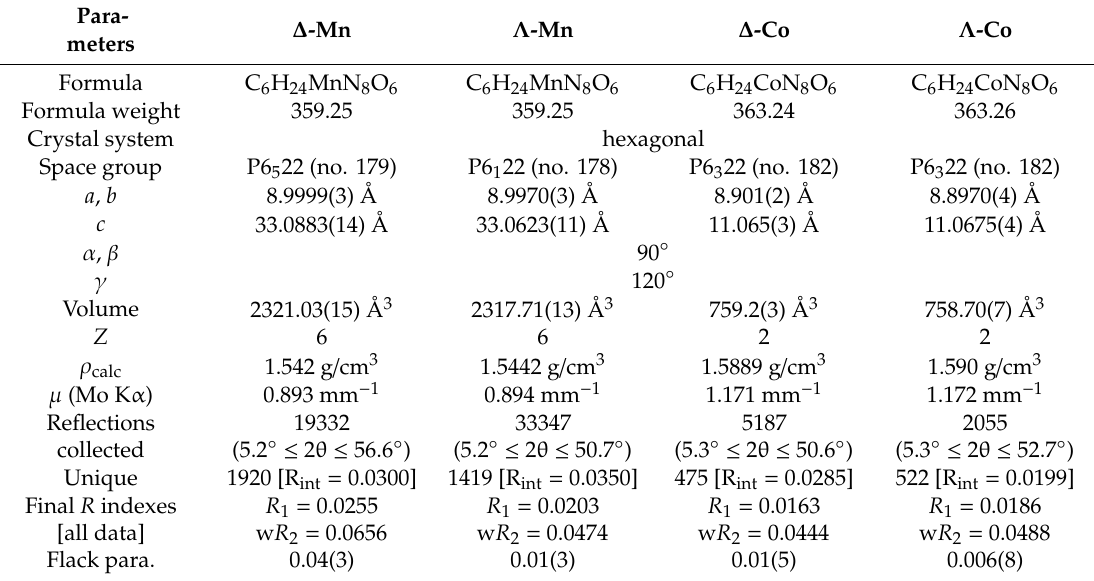
Table 3. Data and structure refinement for [M(en) 3 ](NO 3 ) 2 at 120